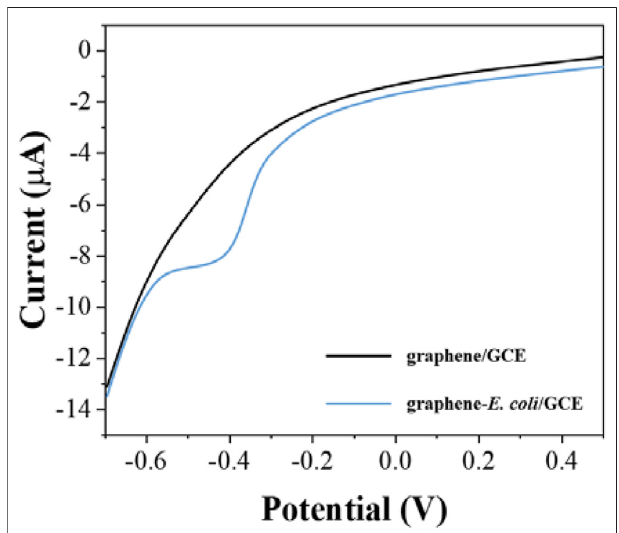
FIGURE 2 | DPV curves of graphene/GCE and graphene- E. coli /GCE in PBS (pH (cid:2) 7).